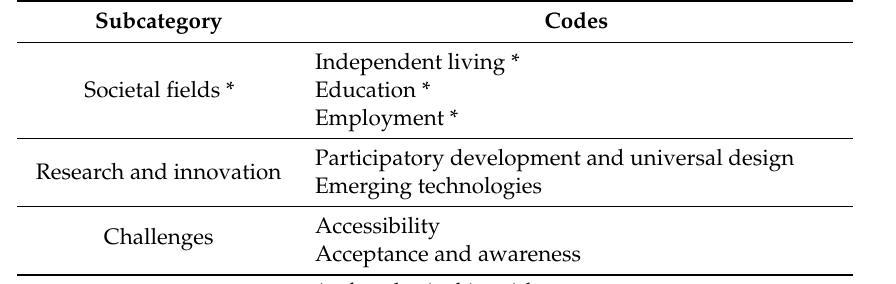
Table A3. Set I—Needs and Perceptions of ATs.